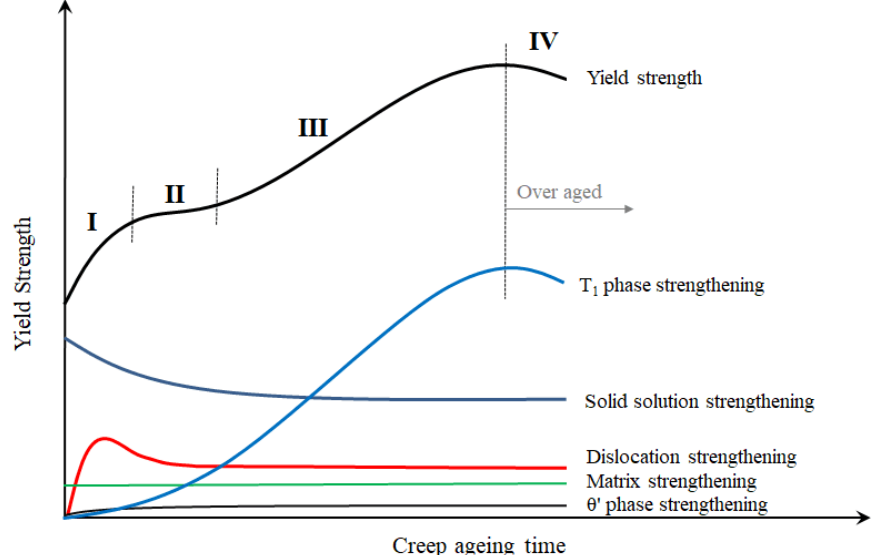
Figure 10. Schematic diagram of the supposed contribution of each strengthening mechanism to the yield strength of Al-Li-S4 alloy.